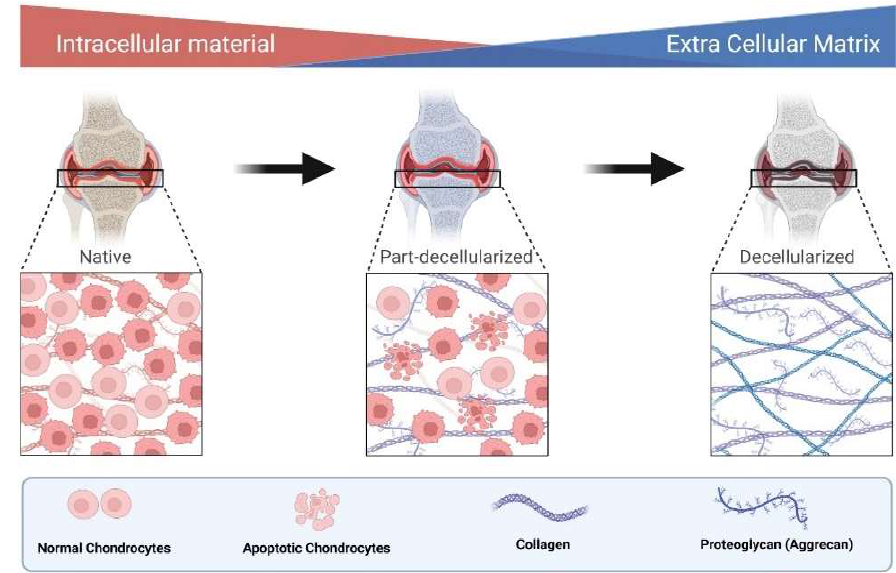
Figure 3. Role of collagen and aggrecan mediated ECM in decellularization.